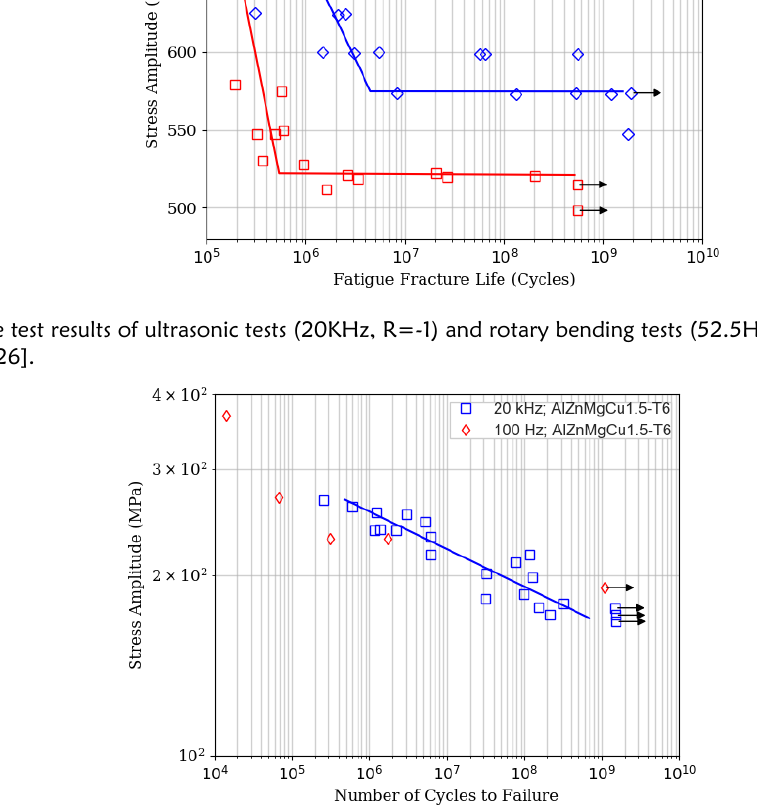
Figure 16: Comparison of fully reversed fatigue testing (100Hz, R=-1) and Ultrasonic fatigue testing at (20kHz, R=-1) on aluminum alloy